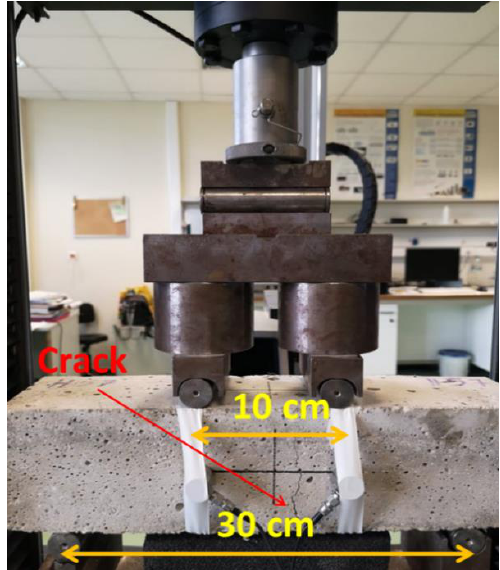
Figure 4. Concrete specimen reinforced with hooked fibers after a bending test with the main crack visible.